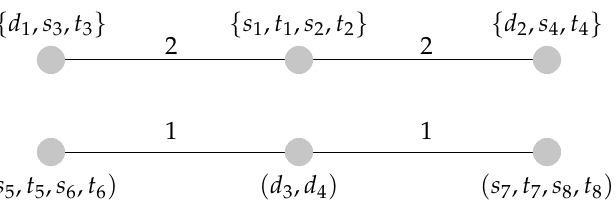
Figure 5. A worst-case instance for the CA lat of CS lat , s = t